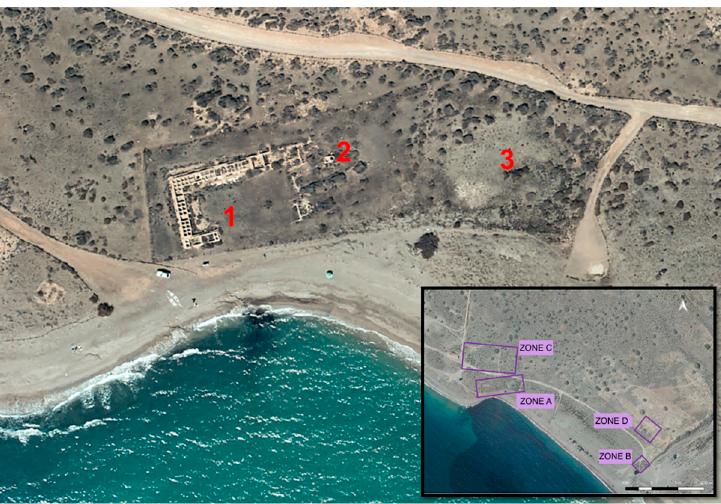
Figure 2. Zone distribution of the archaeological site (zones and areas).